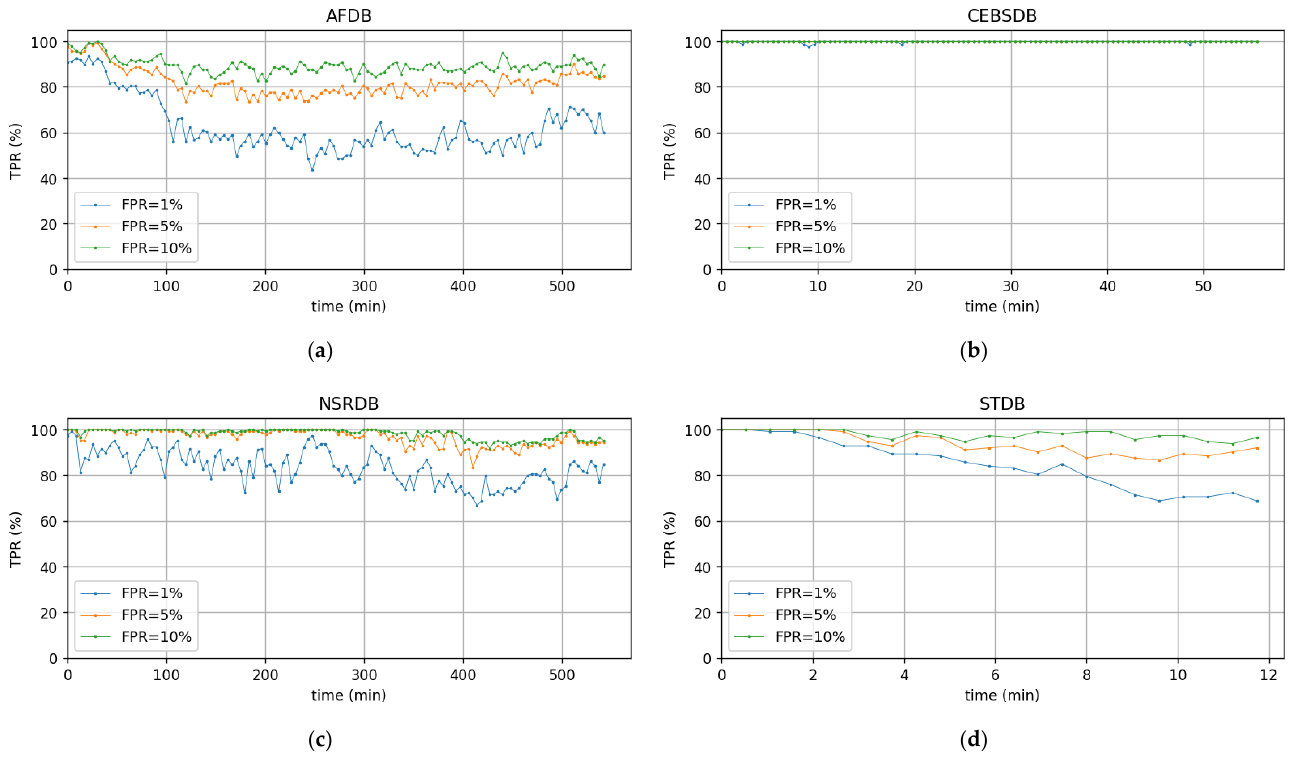
Figure A5. TPR of individual verification is plotted against time separation when FPR is at 1%, 5%, and 10% for: ( a ) AFDB, ( b ) CEBSDB, ( c) NSRDB, ( d ) STDB.